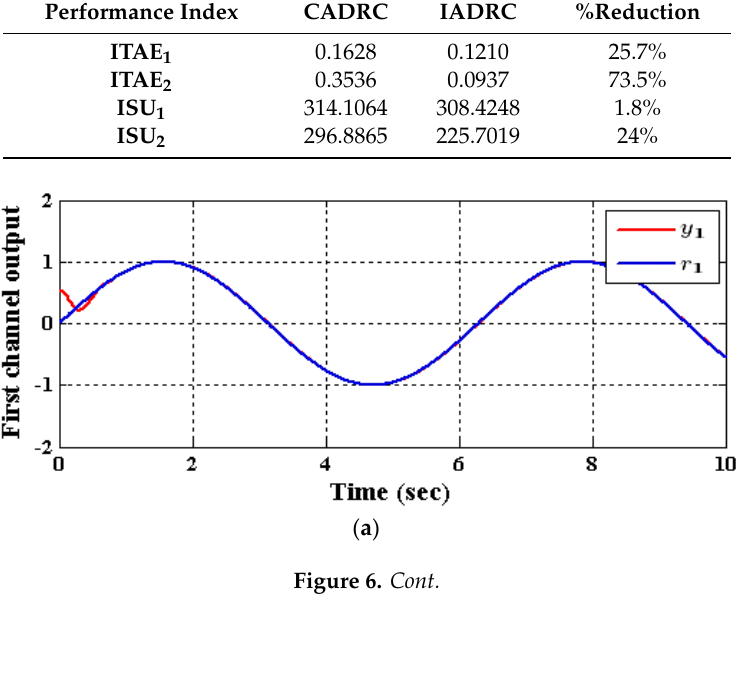
of Figure 3 to validate the output tracking capability of the decoupling control scheme using both CADRC and IADRC configurations. The performance indices for the two configurations are listed in Table 3. While the output responses of the numerical simulations for the decoupled ADRC scheme are shown in Figure 6; Figure 7, respectively. Table 3. Performance of the decoupled ADRC scheme [23].